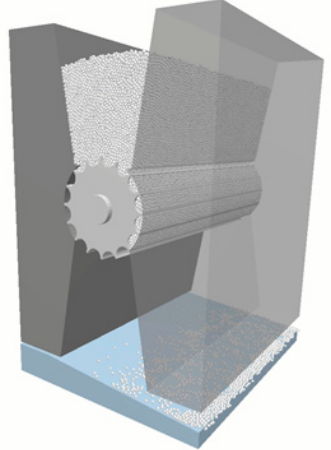
Figure 6. Schematic of the virtual dosing wheel equipment used in the DEM simulations.